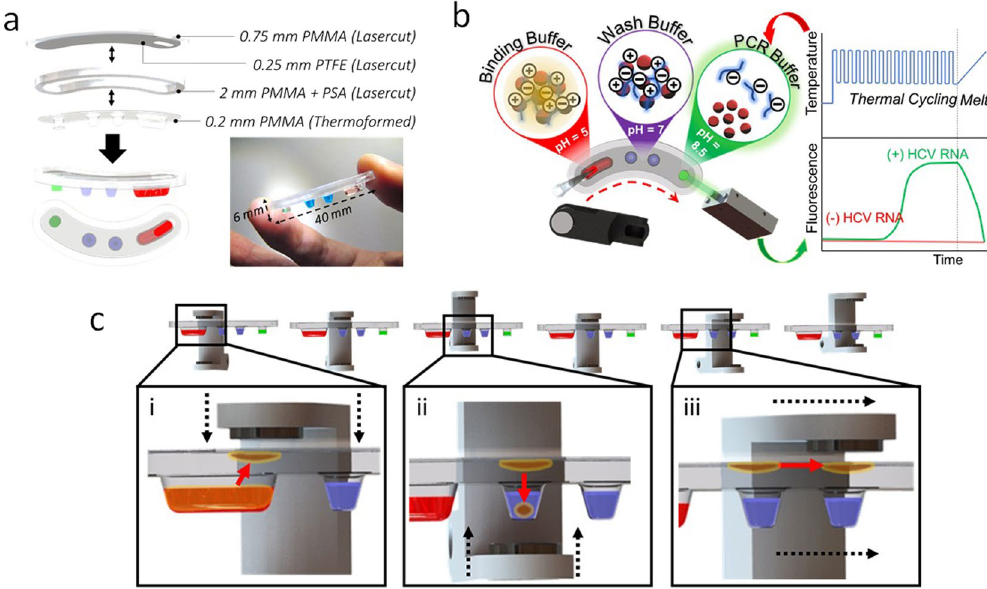
Figure 2. Cartridge Design. ( a ) Cartridges are fabricated with three parts: a lasercut top layer of poly(methyl methacrylate) (PMMA) with a coating of poly(tetrafluoroethylene) (PTFE) tape for smooth particle plug transfer between wells, a middle laser cut layer of PMMA as a spacer for containing silicone oil in the transition region between wells, and a bottom vacuum-formed PMMA layer with extruded wells for containing reagents. Pressure sensitive adhesives (PSA) applied to both surfaces of the middle spacer generates a leak-proof seal upon cartridge assembly. ( b ) Overview of nucleic acid purification and PCR assay droplet reagents with their arrangement within cartridge wells. Samples of interest are injected with magnetic particles into the first well containing 40 µ l of a binding buffer (pH = 5) through an opening in the top of the cartridge. At this low pH, the polyhistidine coating of the magnetic particles is positively-charged, which allows binding to negatively-charged nucleic acids by electrostatic forces. Transfer of magnetic particles through two wash buffers (pH = 7) purifies the captured nucleic acids via desorption of unbound cellular debris or proteins that may inhibit the PCR reaction. Final transfer into the PCR solution (pH = 8.5) neutralizes the charge of the magnetic particle surface allowing for elution of nucleic acids for thermal cycling and subsequent melt analysis coupled with fluorescence detection. ( c ) Particle transfer actuation is accomplished by (i) descent of the upper magnet to draw particle plug into oil for collection at the PTFE surface, (ii) ascent of the lower magnet to introduce particle plug into reagent droplets, and (iii) magnet rotation for particle transfer between